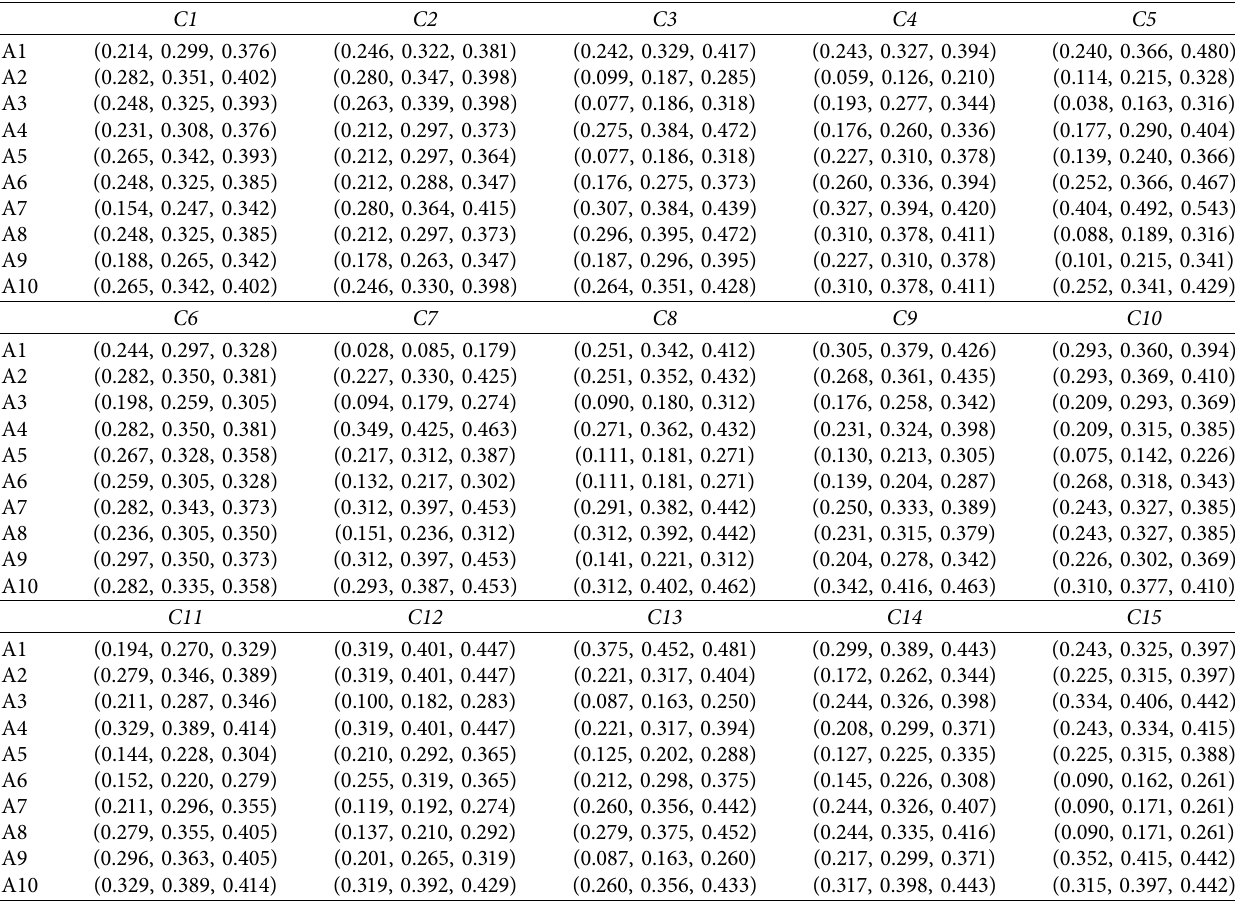
Table 9: Normalized fuzzy evaluation matrix ( 􏽦 Z ∗ ).